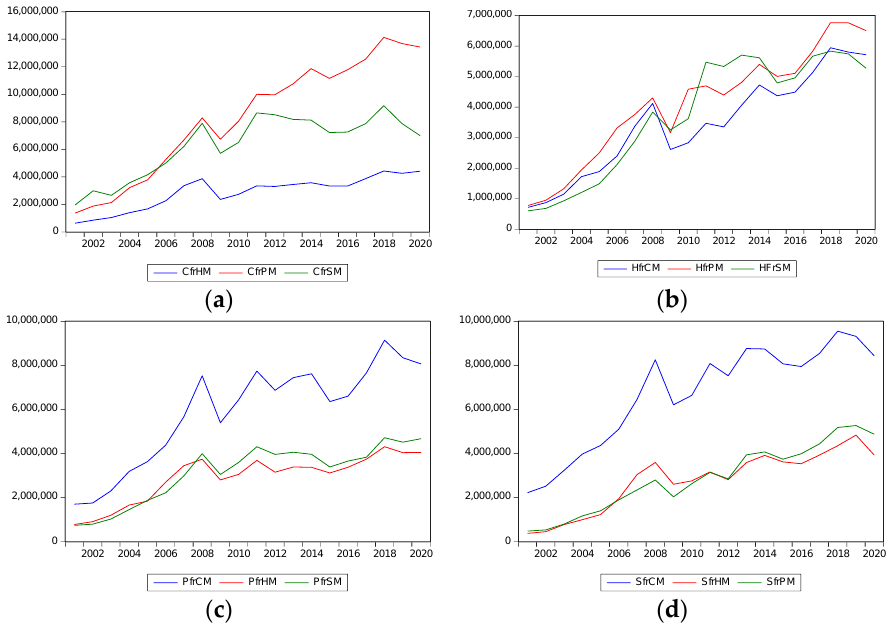
Figure 2. Imports of the countries from the other V4 members: ( a ) Czech Republic; ( b ) Hungary; ( c ) Poland; ( d ) Slovakia.